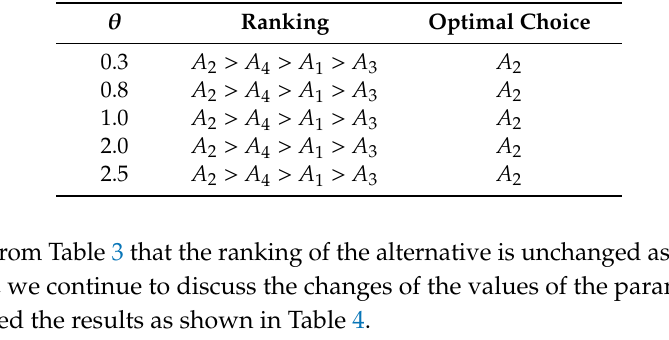
Table 3. The ranking of the alternative under di ff erent parameters θ .